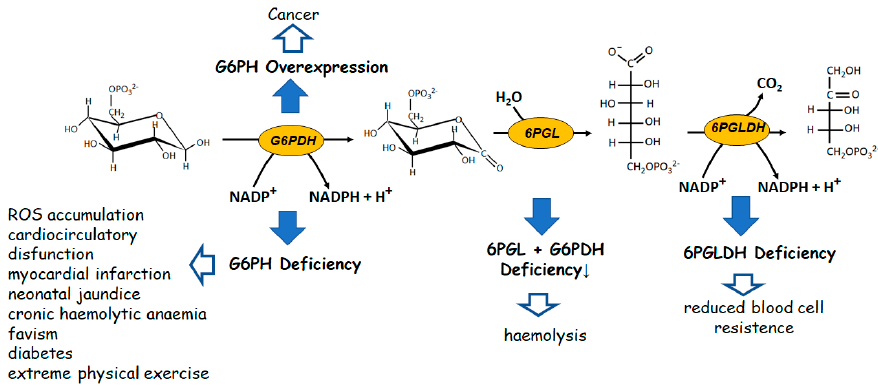
Figure 1. The oxidative branch of PPP. Alterations in enzymatic activities are connected and/or ob–served in the indicated pathological and stressful conditions, as mentioned in the text.